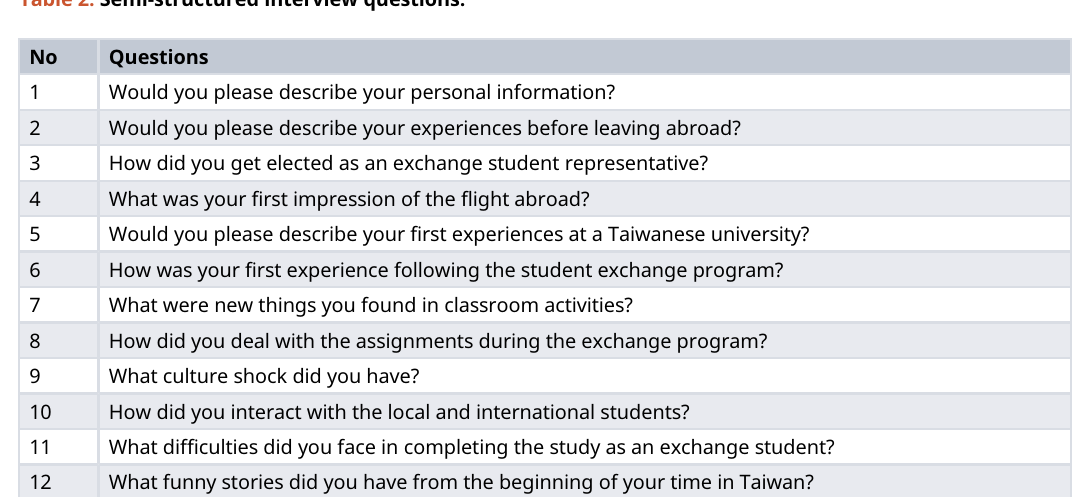
Table 2. Semi-structured interview